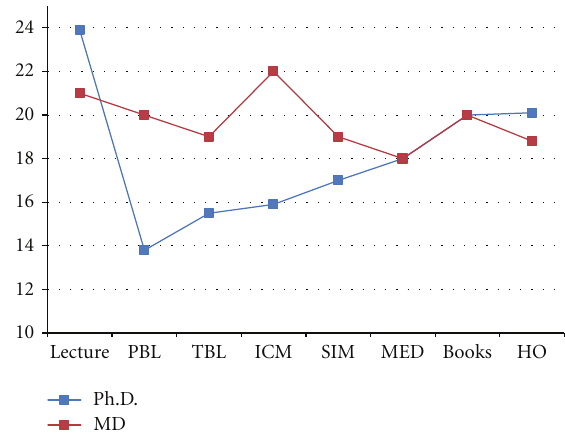
Figure 2: Ratings of faculty members holding either a Ph.D. or MD degree.